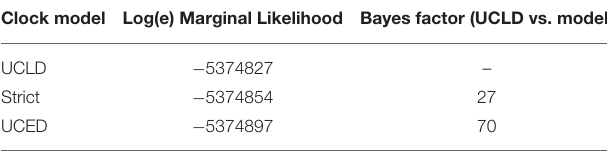
TABLE 1 | Model selection based on path sampling Log-Marginal